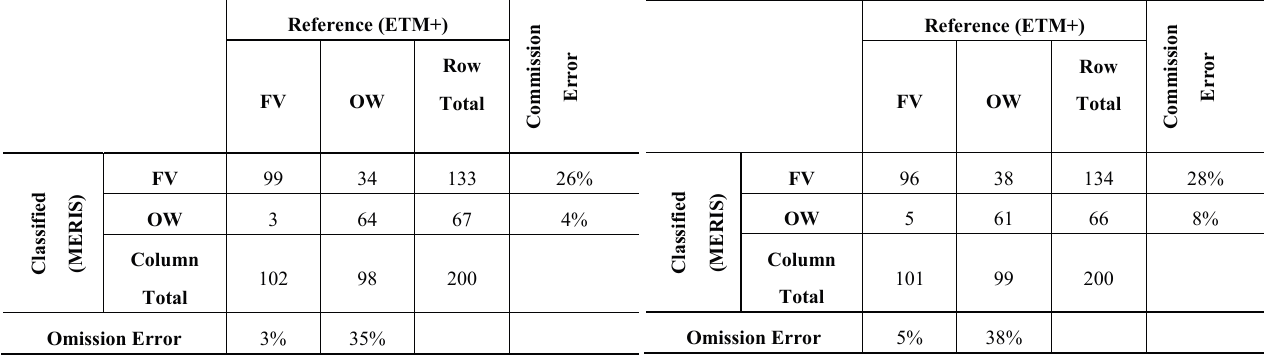
Table 4. Error matrices for image pair 1 ( left ) and pair 2 ( right ) showing performances of Maximum Likelihood in the classification of floating vegetation (FV) and open water